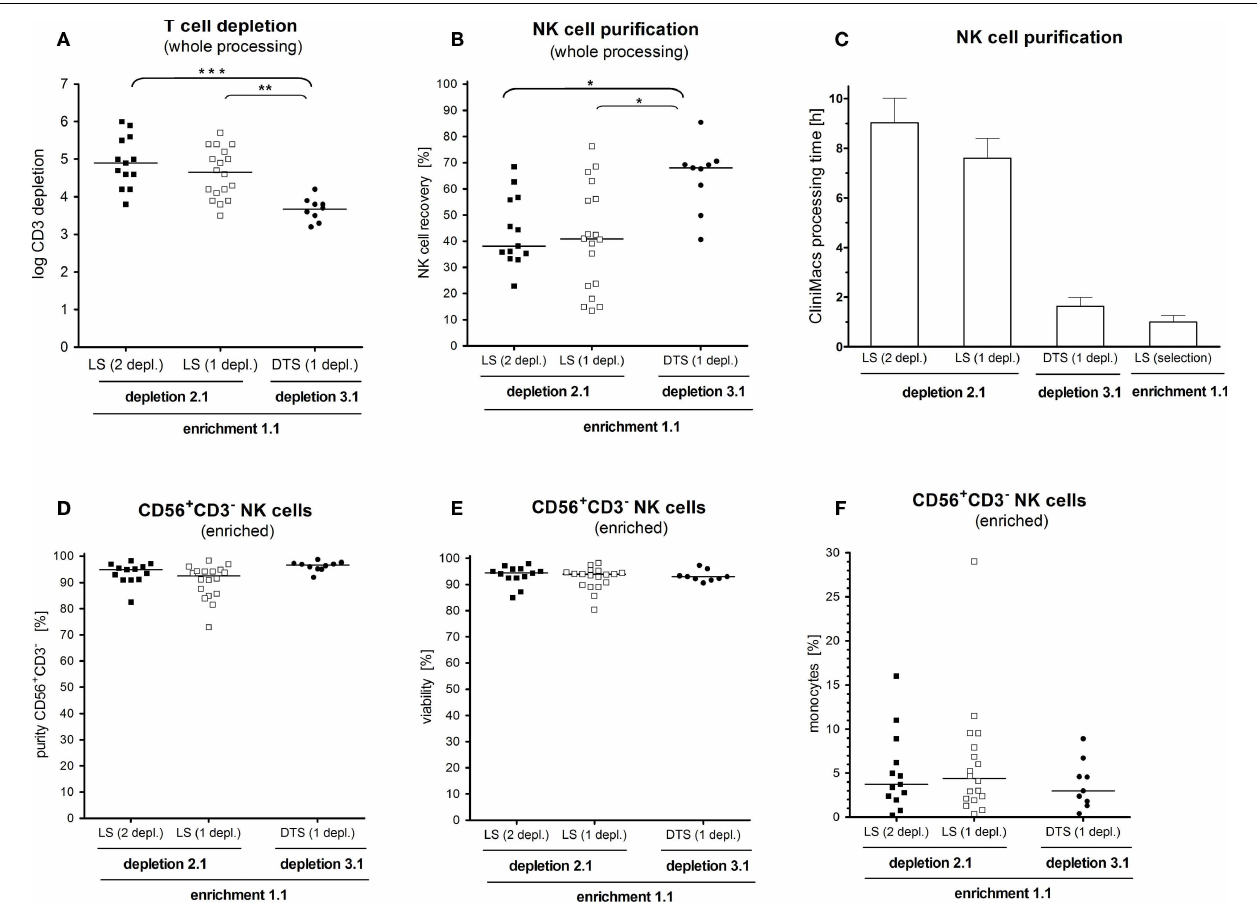
FIGURE 3 | Impact of cell processing on NK cell yield, purity, andT-cell depletion. NK cells were enriched by either the depletion 2.1 program in a doubleT-cell depletion round using an LS purification set (depletion 2.1, 2 depl. n = 13), the same program using only oneT-cell depletion